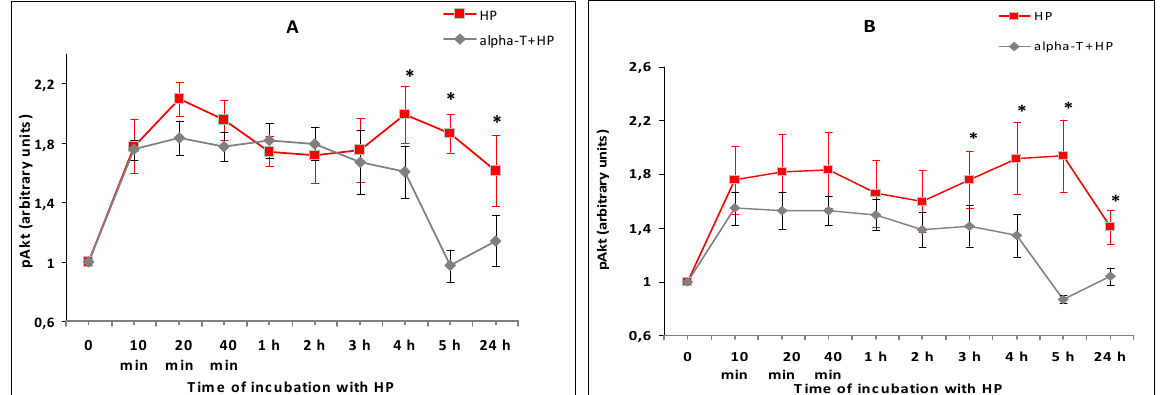
Figure 10. The figure shows effect of pre-incubation of PC12 cells with 100 nM and 100 μ M α -T for 18 h prior to exposure of cells to 0.3 mM H O on the activity of Akt (pAkt level). 2 2 The results of five experiments made are shown as means ± SEM. ( A ) Pre-incubation with 100 nM α -T; ( B ) Pre-incubation with 100 μ M α -T. Red lines with square data points show O alone, black lines with diamond data points show effect of H O after effect of H 2 2 2 2 pre-incubation with α -T. On ( A , B ): HP = hydrogen peroxide; alpha-T = α -tocopherol. * The differences are significant according to Students’ paired t test as compared to the level of O , p < pAkt in the PC12 cells exposed to α -T and H 2 2